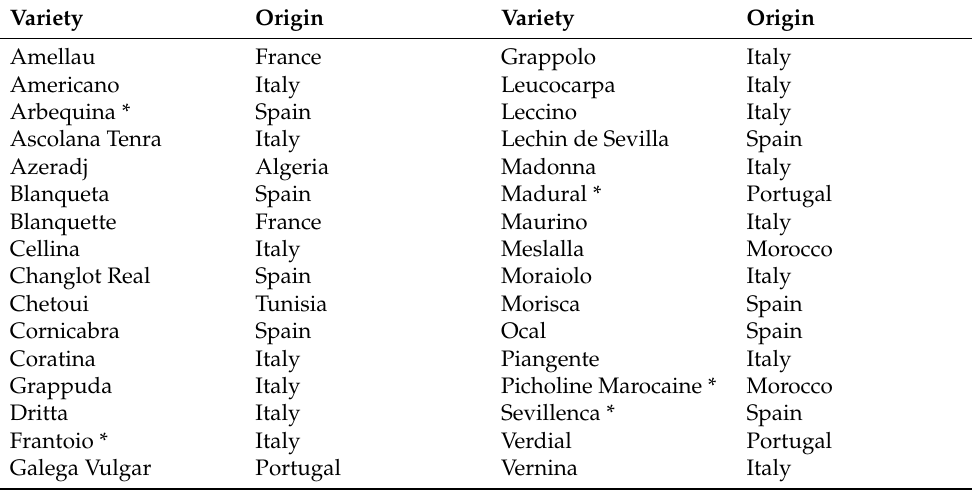
Table 1. List of olive varieties included in the study, with their geographical